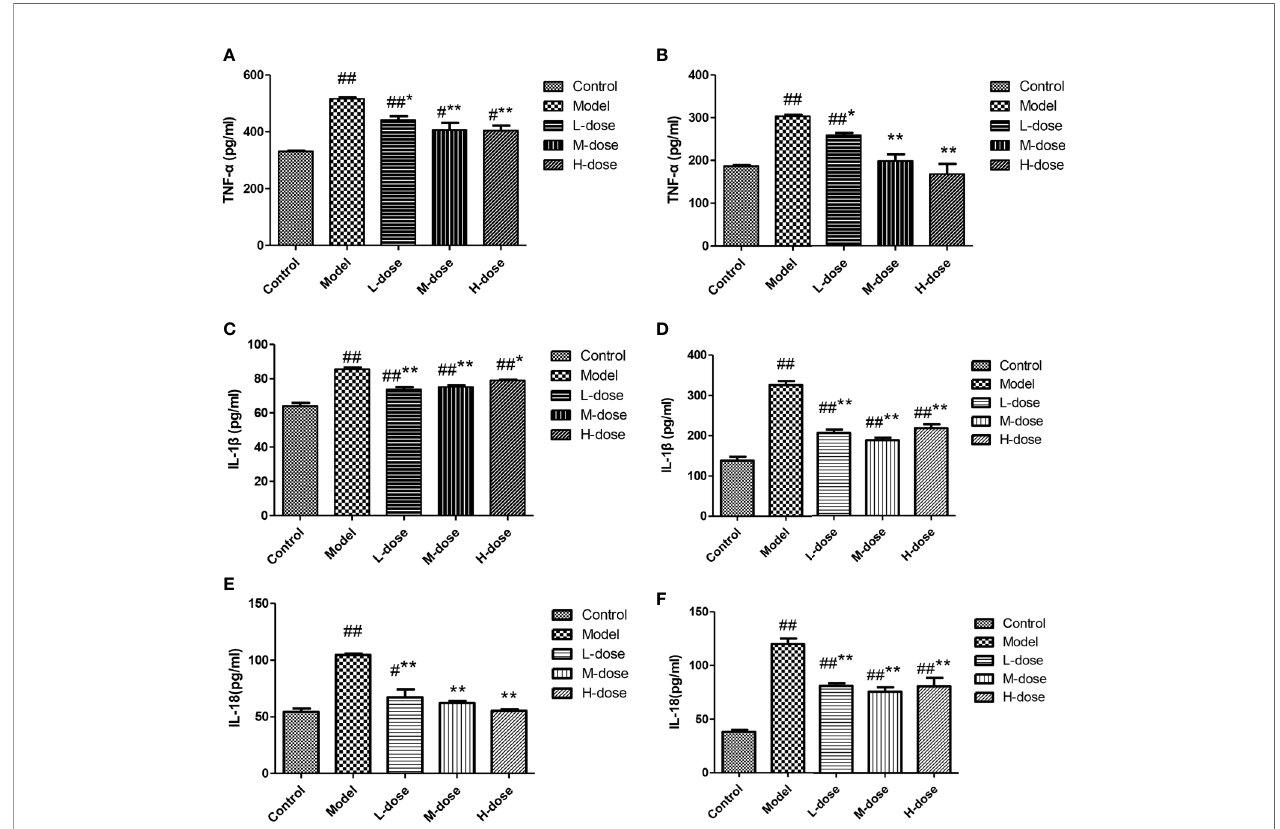
FIGURE 6 | MCME cell was incubated with different concentrations of SLBZS for 24 h. Then, 100 m l of 10 m g/ml DSS was added to each well for 2 h. Subsequently, the supernatant was pipetted, and 100 m l of 1 m g/ml LPS was added and incubated with the cells for 12 h. The effect of SLBZS on proin fl ammatory factors. Commercial TNF- a , IL-1 b , and IL-18 kits were used to measure colon tissue (A, C, E) and cellular (B, D, F) proin fl ammatory factor levels. The data are shown as the mean ± S.E.M. # P < 0.05, ## P < 0.01 vs. the control group; * P < 0.05, ** P < 0.01 vs. the model